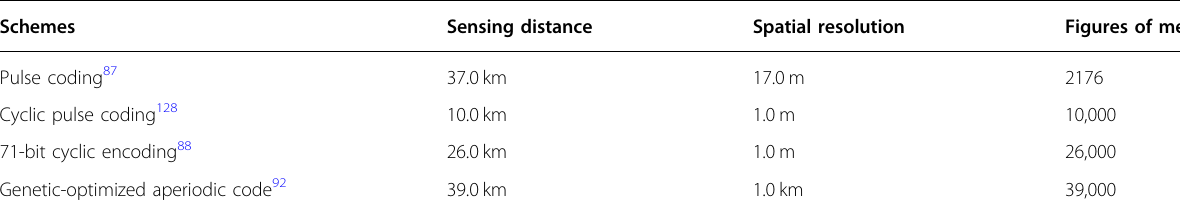
Table 6 Performance index of the pulse coding scheme Schemes